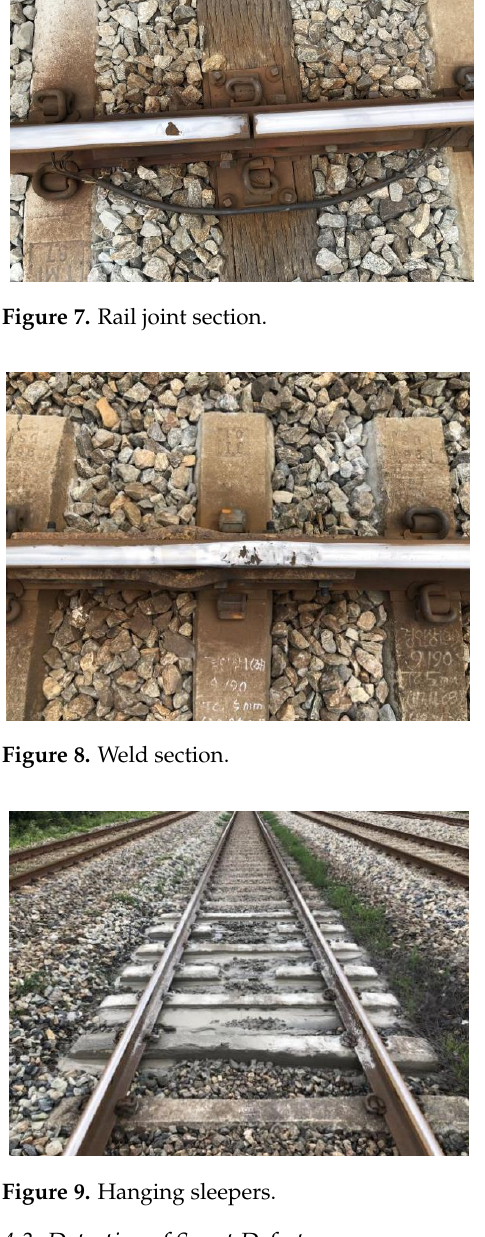
Figure 6. Vertical and horizontal squats.